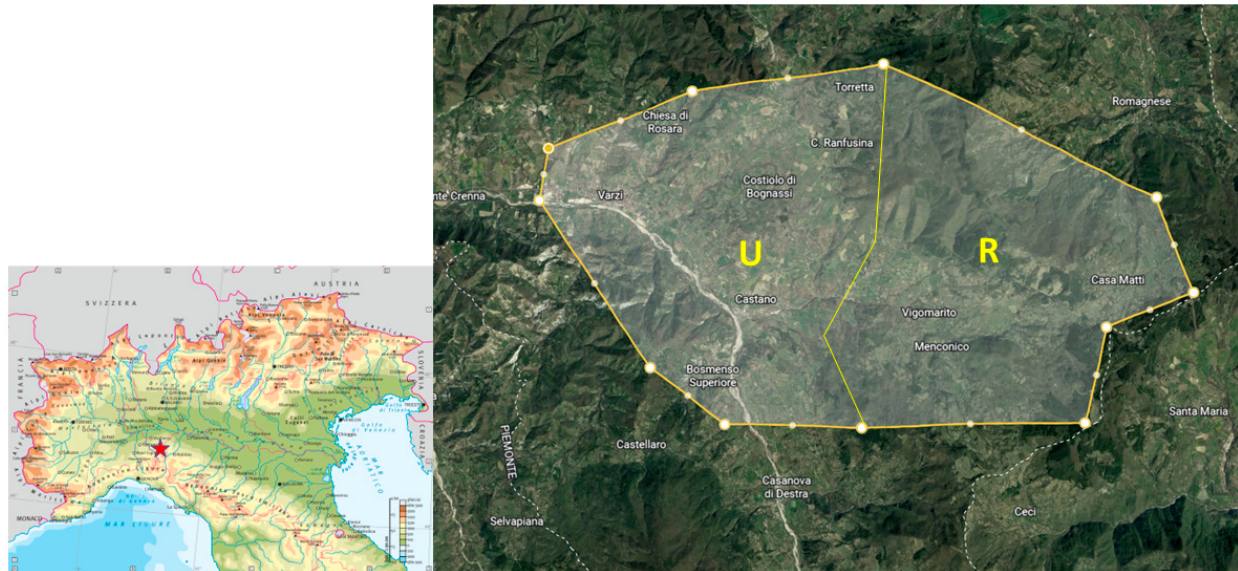
Figure 1. Map of the sampling area. U: Urbanized area; R: Rural area. Table 1. ICP-OES device parameters for determination of trace and toxic